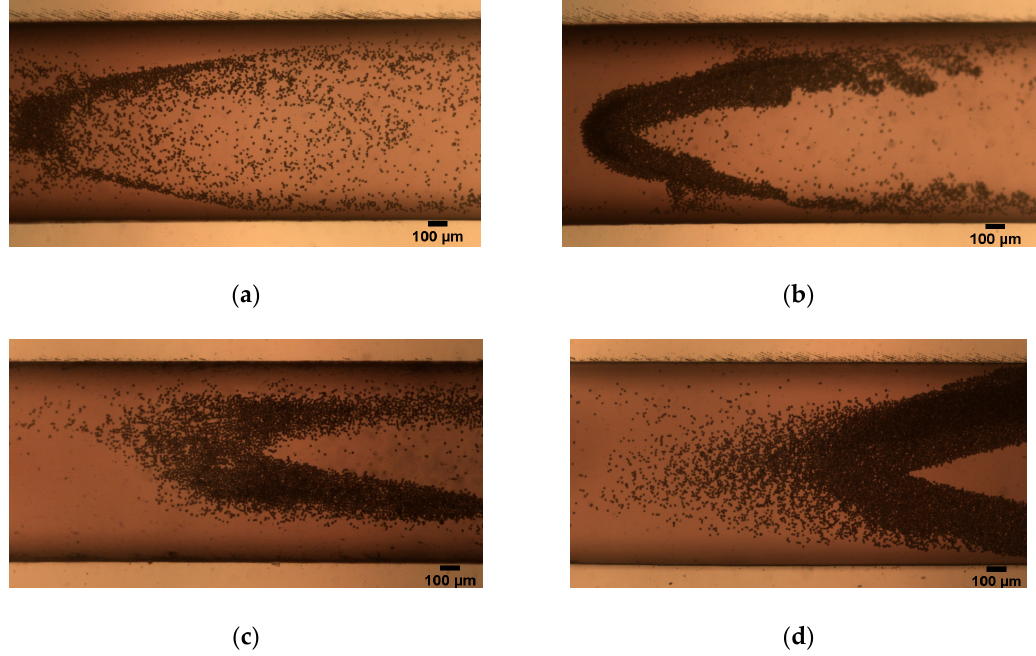
Figure 10. A loop formed below the critical flow rate. The vertical magnetic field ( θ = 0°): ( a ) Br = 1.2 T, Q = 10 μ L/min ( Re = 0.01) and ( b ) Br = 2.4 T, Q = 30 μ L/min ( Re = 0.42); the inclined magnetic field ( θ = 10°): ( c ) Br = 1.2 T, Q = 20 μ L/min ( Re = 0.28) and ( d ) Br = 2.4 T, Q = 50 μ L/min ( Re = 0.71).